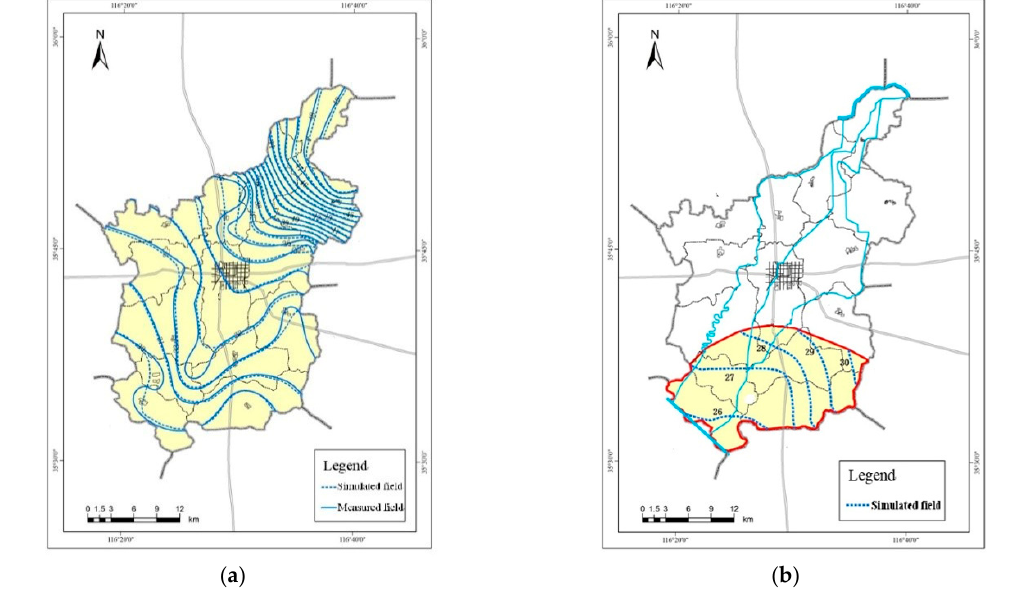
Figure 7. ( a ) Flow field curve of the first layer; ( b ) flow field curve of the second layer.